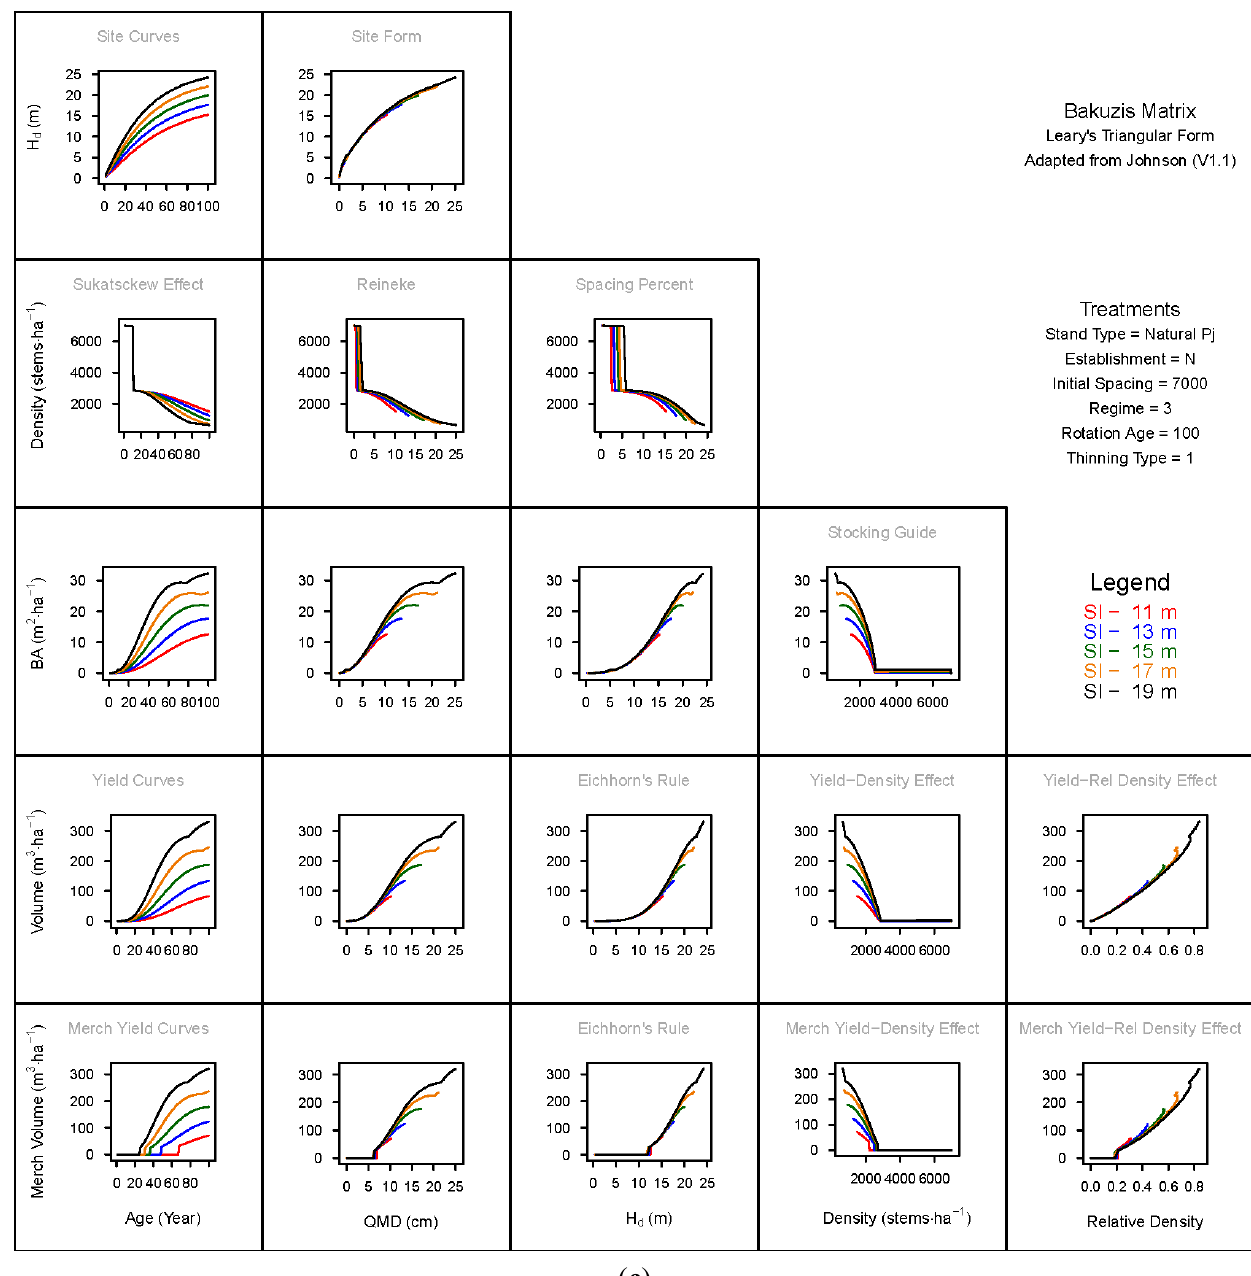
Figure A2. Bakuzis matrices for unthinned and precommercially thinned (PCT) jack pine (Pj) stands which were established naturally (N) at an initial densities of 7000 stems/ha and grown on 5 site qualities (SI) over 100 year rotations: ( a ) Regime 1 represented unthinned control stands; ( b ) Regime 2 was initially identical to Regime 1 but the stands were subjected to a single PCT treatment at a stand age of 10 years in which stand densities were reduced to 2862 stems/ha and the maximum thinning response model setting was employed; and ( c ) Regime 3 was identical to Regime 2 but the stands utilized the minimum thinning response model to account for accelerated growth arising from the PCT